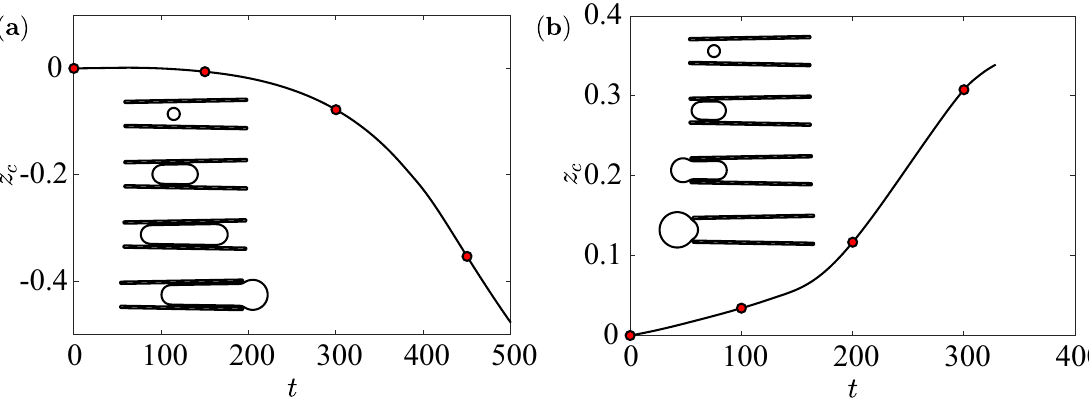
Figure 10. Cone position versus time when ( a ) z b ( 0 ) = 4 and ( b ) z b ( 0 ) = 2. The insets show snapshots corresponding to the